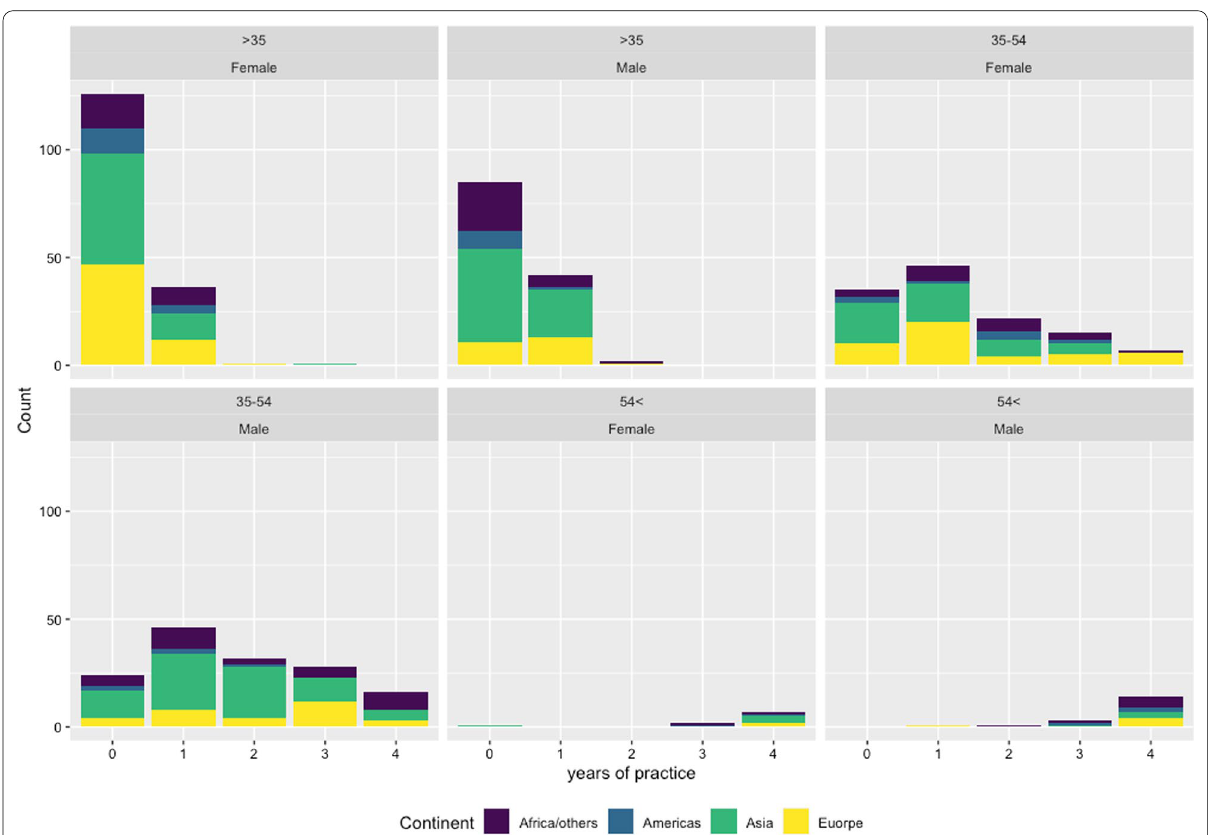
Fig. 1. A bar plot showing the survey participants’ characteristics according to age, gender, and geographic location